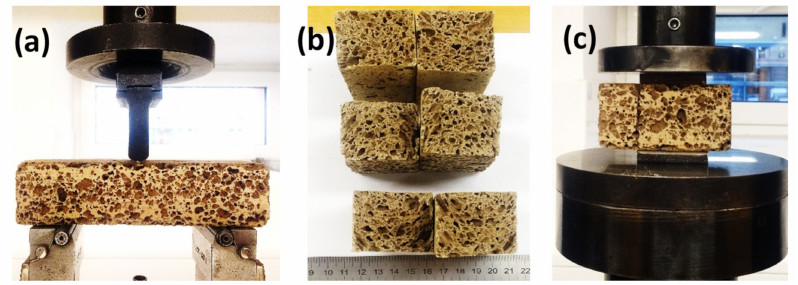
Figure 1. ( a ) Three-point flexure test, ( b ) broken samples, ( c ) compression